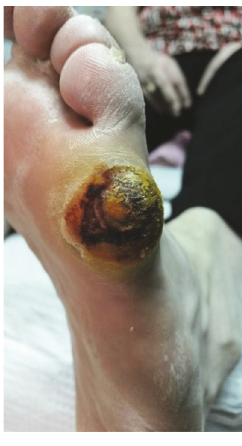
Figure3:Representativemediumpowerimageoftheverrucouscar- cinomademonstratesprominentsurfacehyperkeratosisandmarked epidermal acanthosis, with a combined exophytic and endophytic growth pattern. Cytologic atypia is only mild to moderate. Rather than the infiltrative pattern typically seen at the deep edge of con- ventional invasive squamous cell carcinoma, verrucous carcinoma demonstrates insidious pushing-type invasion by expansile and irregular rete pegs (4x, H&E